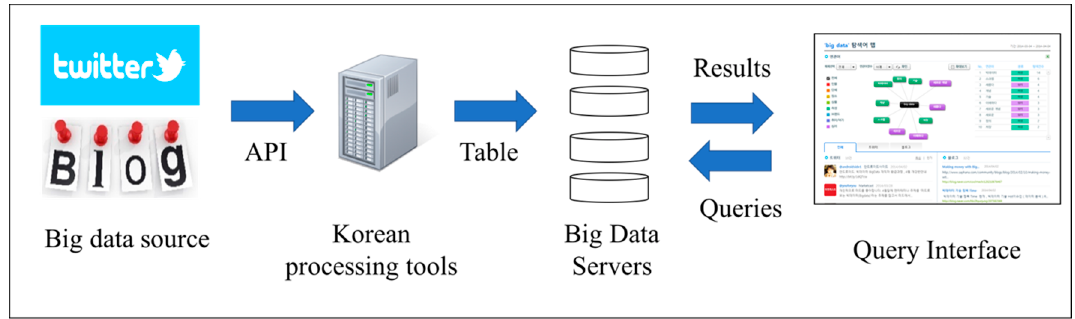
Figure 6. SOCIAL Metrics for searching tweets and blog